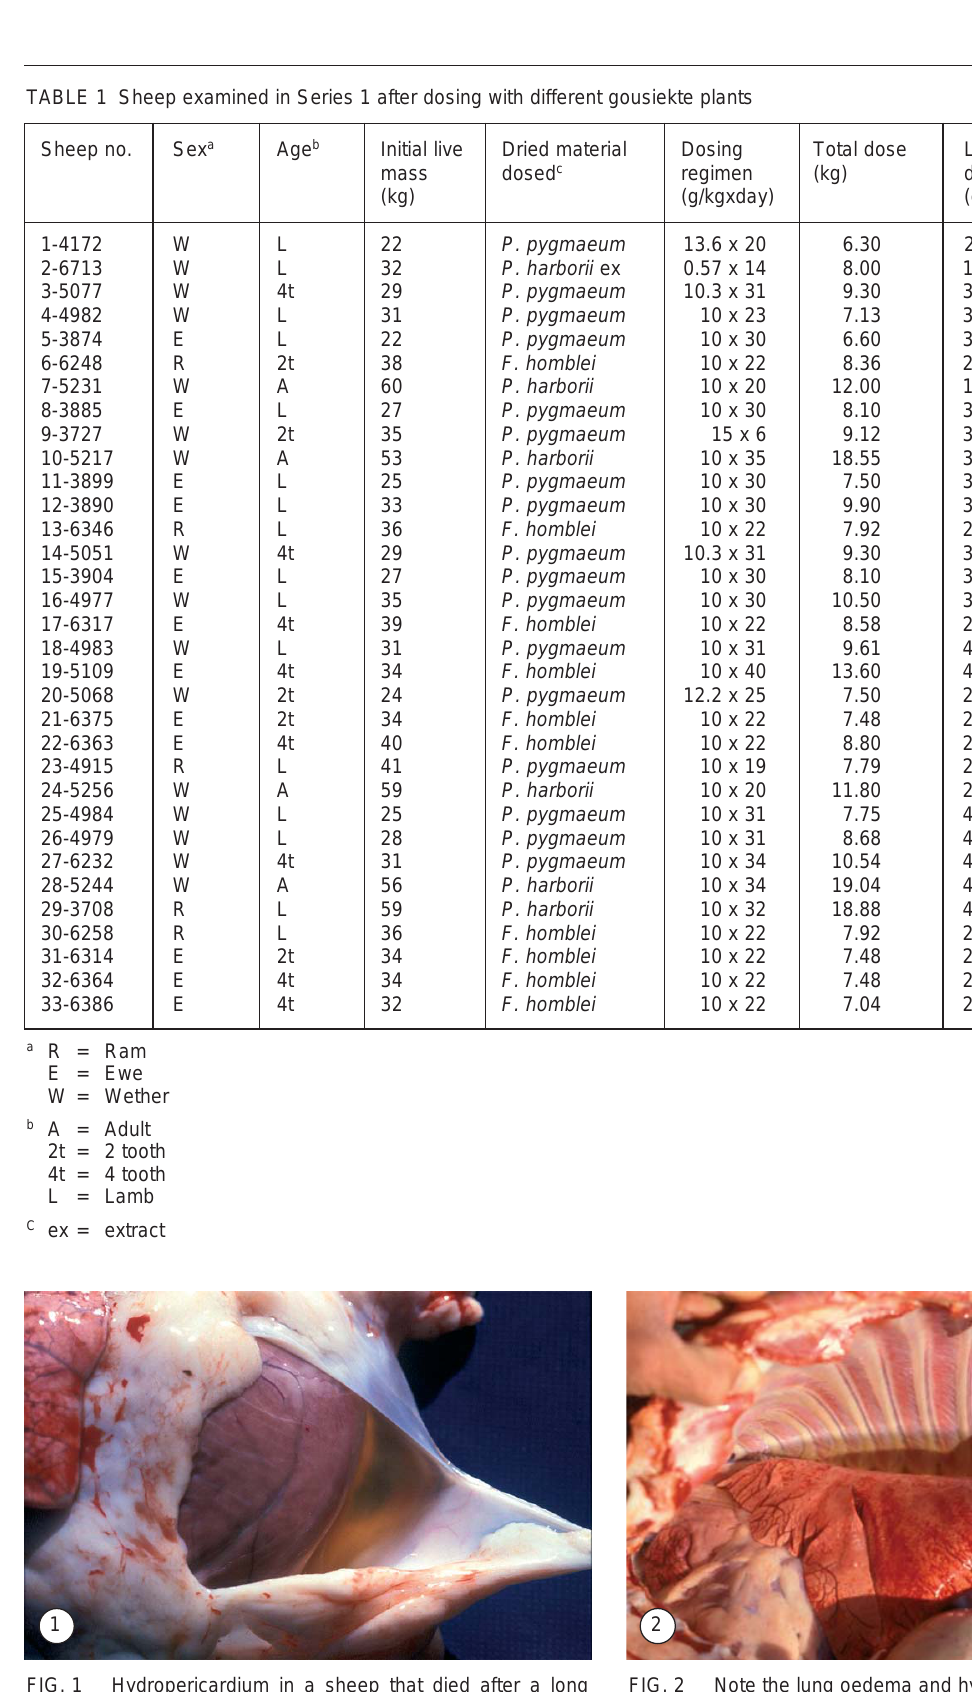
FIG. 2 Note the lung oedema and